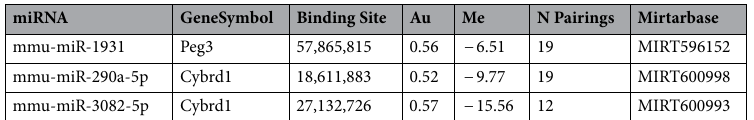
Table 1. Prediction analysis of mirNA-mrna interactions of common